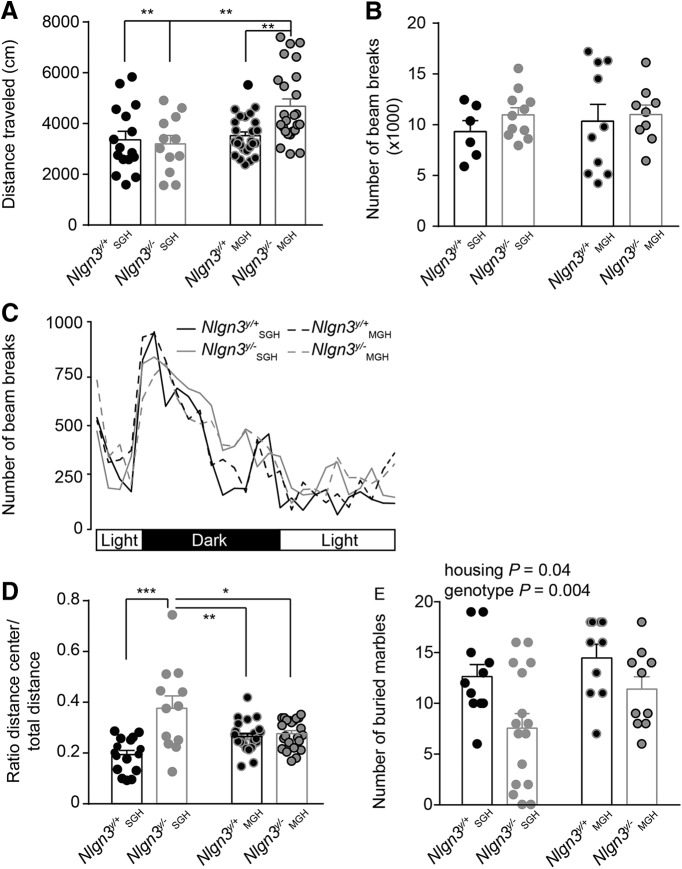
Increased anxiety in adult (2- to 4-mo-old) Nlgn3y/– mice from MGH. A, Increased distance traveled in OF in Nlgn3y/– mice from MGH compared to Nlgn3y/– mice in SGH and Nlgn3y/+. B, No change in the average number of beam breaks per hour recorded over 30 h. C, Number of beam breaks per hour over 30 h. D, Increased normalized distance traveled in the center of the OF for Nlgn3y/– mice in SGH compared with Nlgn3y/+ mice from SGH and mice from MGH. E, Increased number of marbles buried by mice in MGH compared with mice from SGH. Nlgn3y/– mice in SGH buried fewer marbles than Nlgn3y/+ mice in SGH. Values are represented as mean ± SEM. Statistical significance was tested by two-way ANOVA and post hoc Sidak’s multiple comparison test. *P < 0.05; **P < 0.01; ***P < 0.001 (A, B, D, and E).